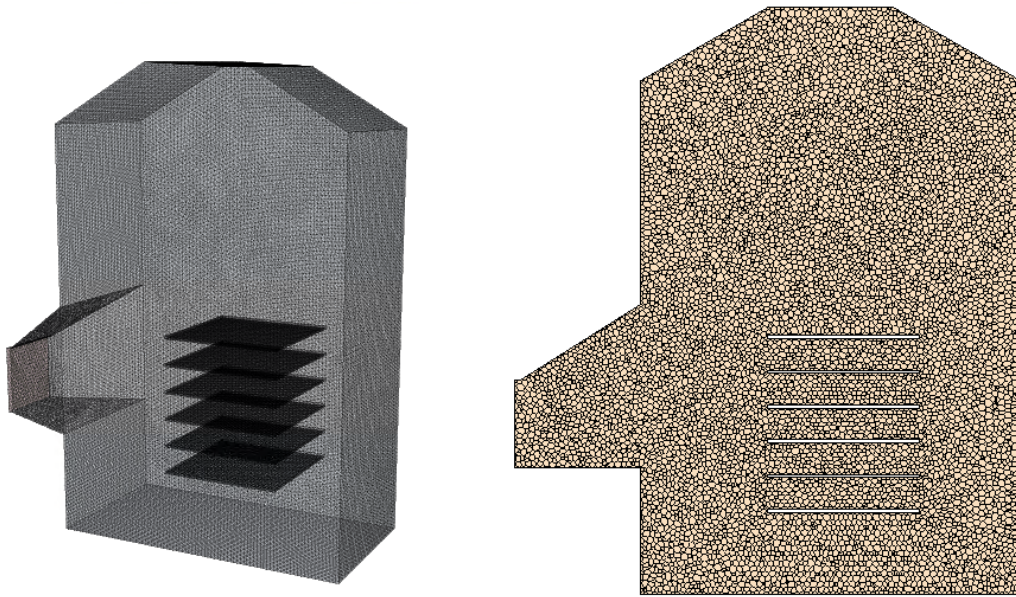
Figure 2. Visualisation of the polyhedral-type mesh in the studied chamber.